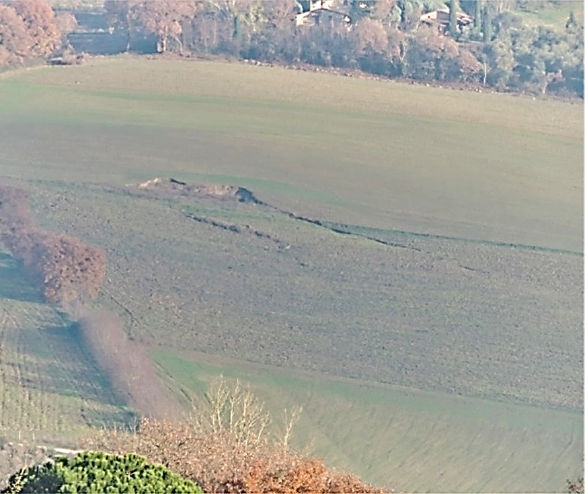
Figure 4. Example of shallow landslide (soil slide) in the study area. Photo taken on 20 December 2020, by CNR-IRPI.